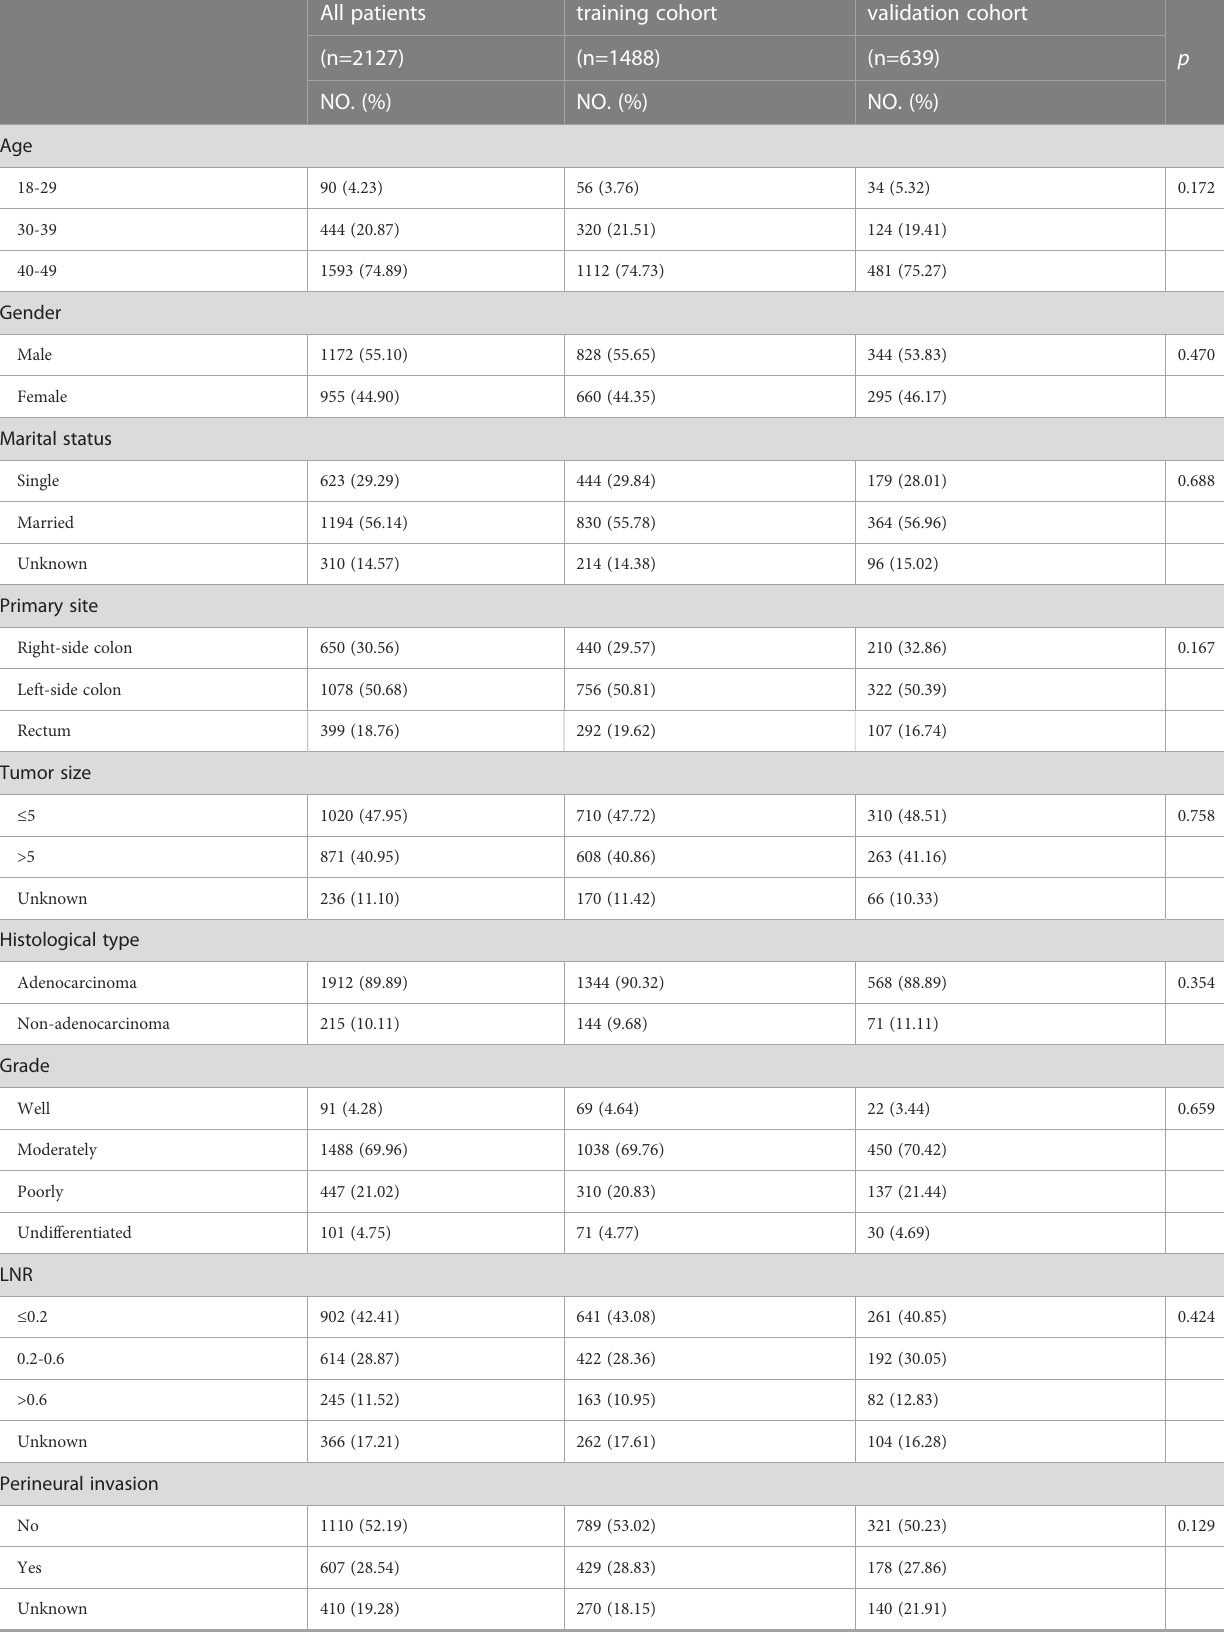
TABLE 1 Clinicopathological characteristics of Young-onset colorectal cancer with synchronous liver metastasis patients from 2010 to 2018. All